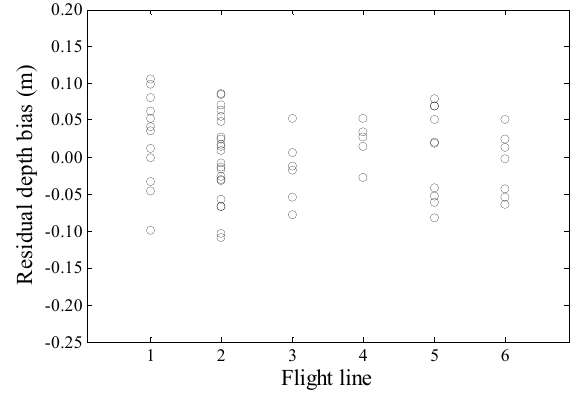
Figure 8. Residual depth bias induced by different flight lines. Flight lines 1, 2, and 5 are from northwest to southeast, whereas lines 3, 4, and 6 are along the opposite flight direction.